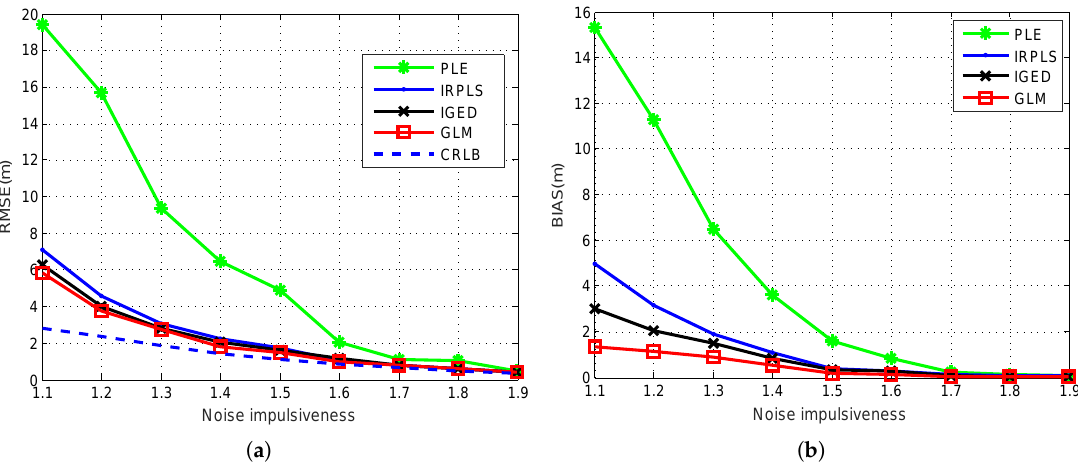
Figure 8. RMSE and bias performance comparison of PLE, IRPLS, IGED and GLM estimates with various noise impulsive- ness. ( a ) RMSE results. ( b ) Bias norm results.